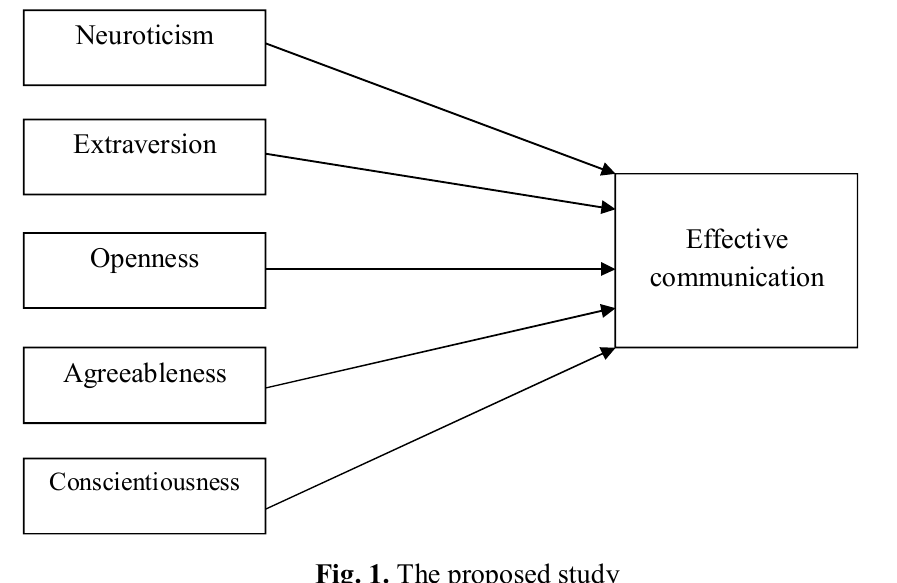
Fig. 1. The proposed